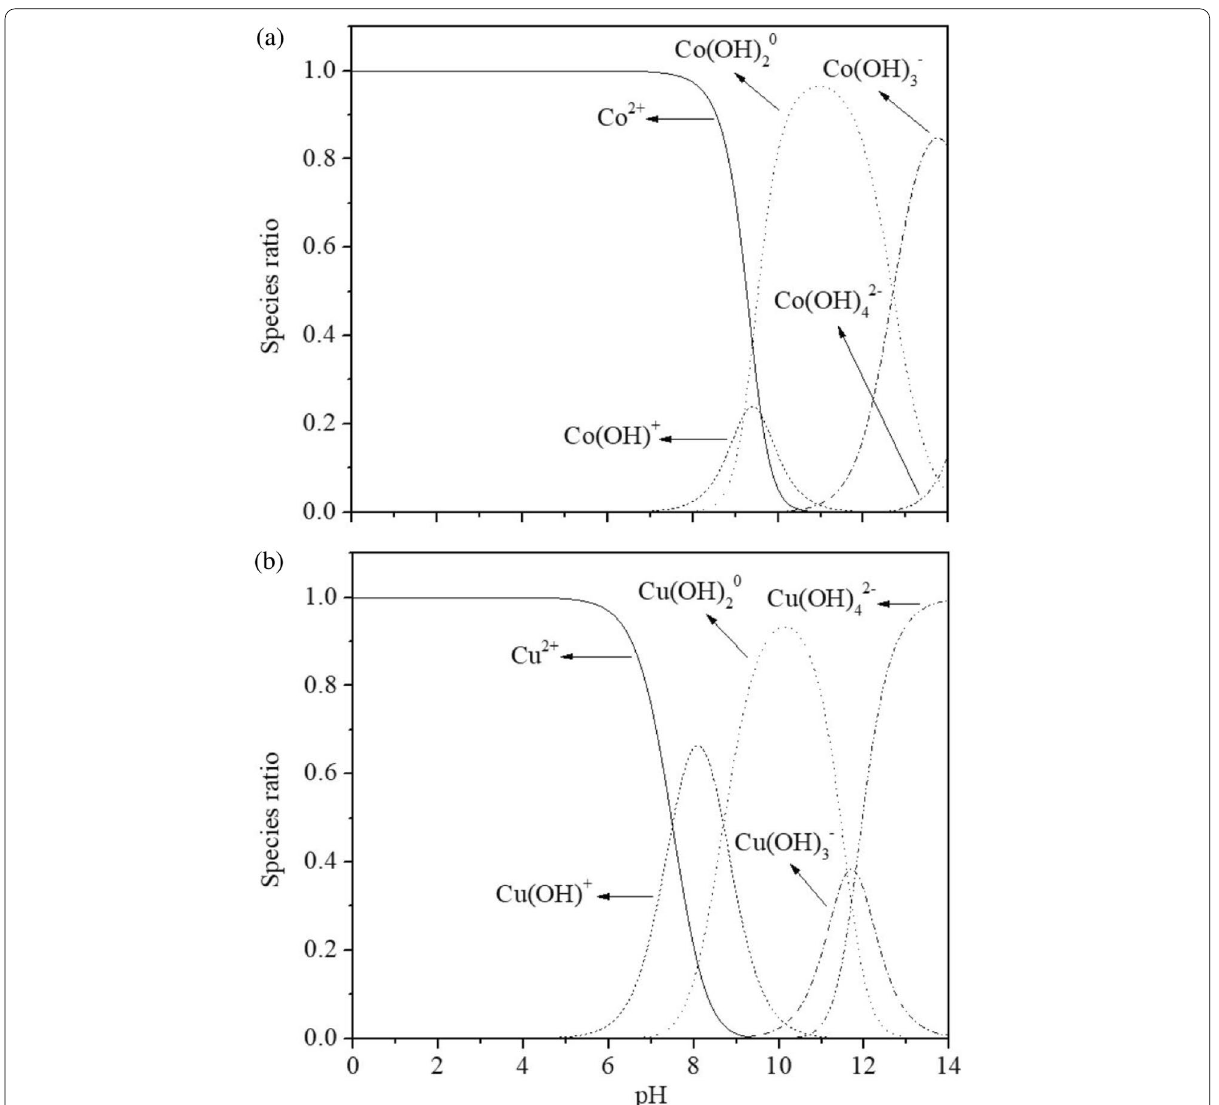
Fig. 2 Speciation of ( a ) cobalt and ( b ) copper for soluble hydro complexes in pure water